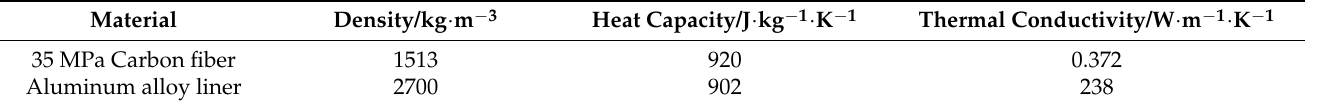
Table 3. Thermodynamic properties of the hydrogen tank